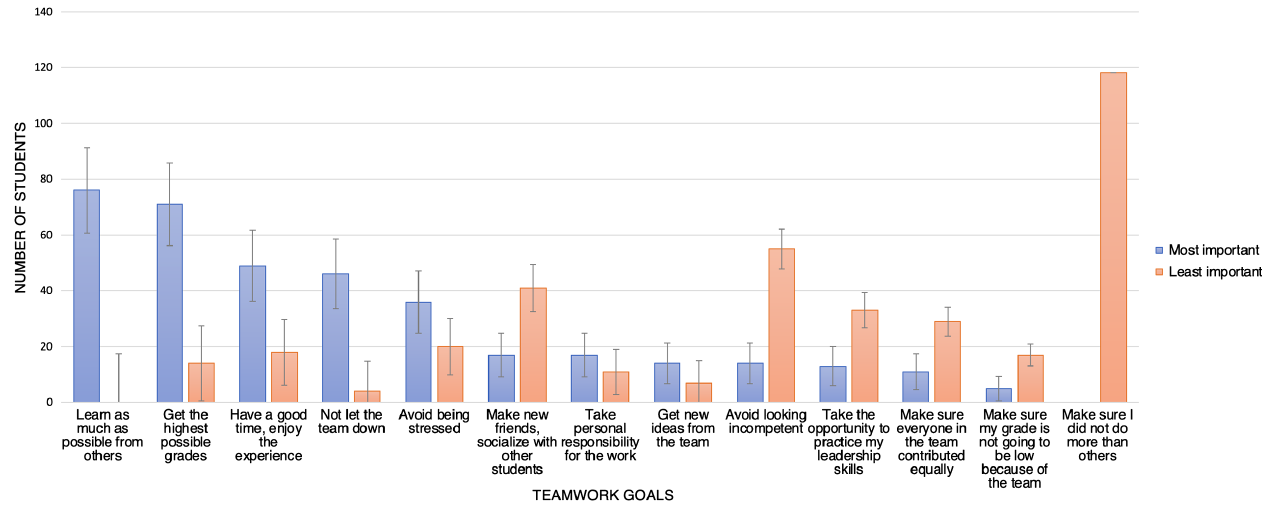
FIG. 2. Most and least important goals as reported by students. Students were asked to choose their “ most important ” and “ least important ” goals from the list of goals shown on the x axis. The blue bars represent the number of students reporting that goal as their most important and the orange bars represent the number of students reporting that goal as the least important. Uncertainties are calculated using the binomial confidence interval with alpha ¼ 95%